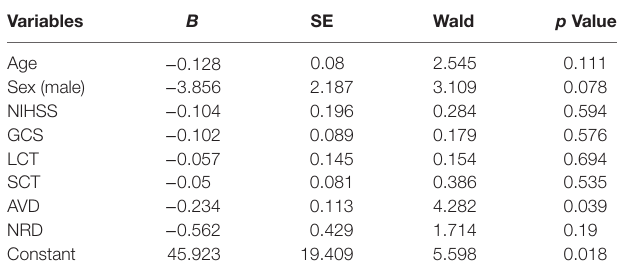
TaBle 2 | Demographic and clinical characteristics of the patients with and without crossed leg sign.